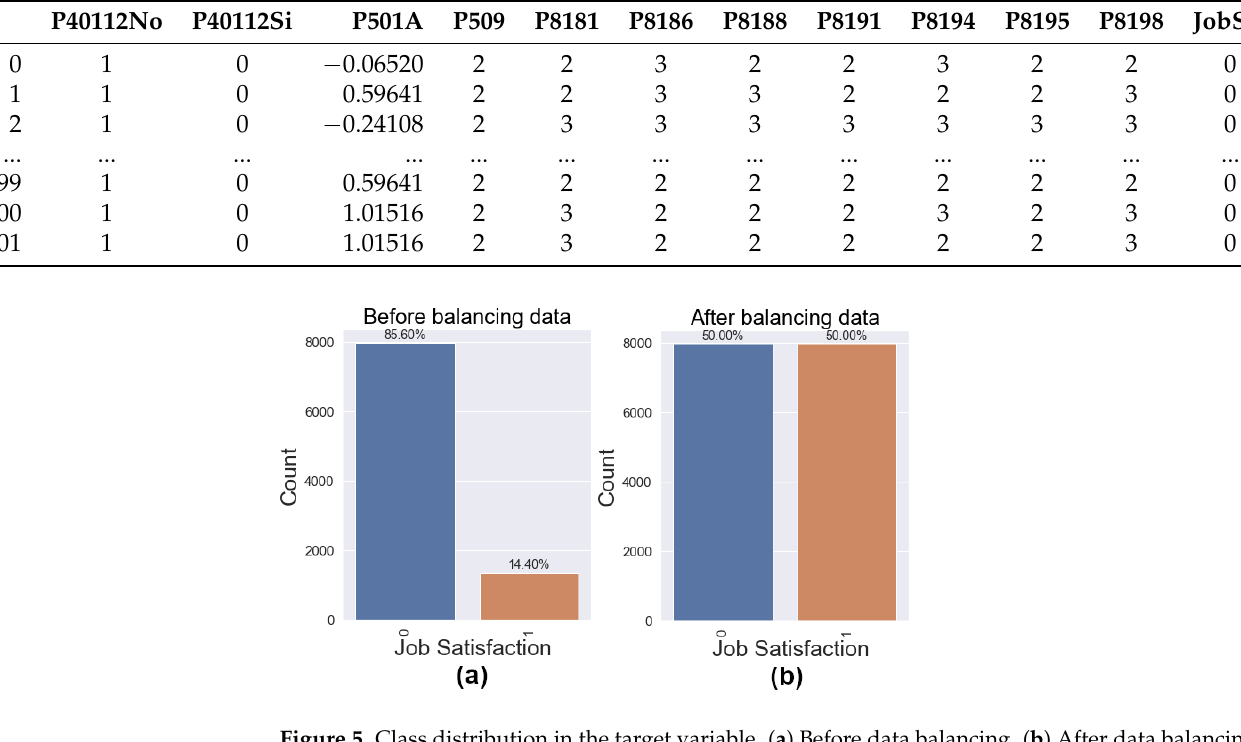
Figure 5. Class distribution in the target variable. ( a ) Before data balancing. ( b ) After data